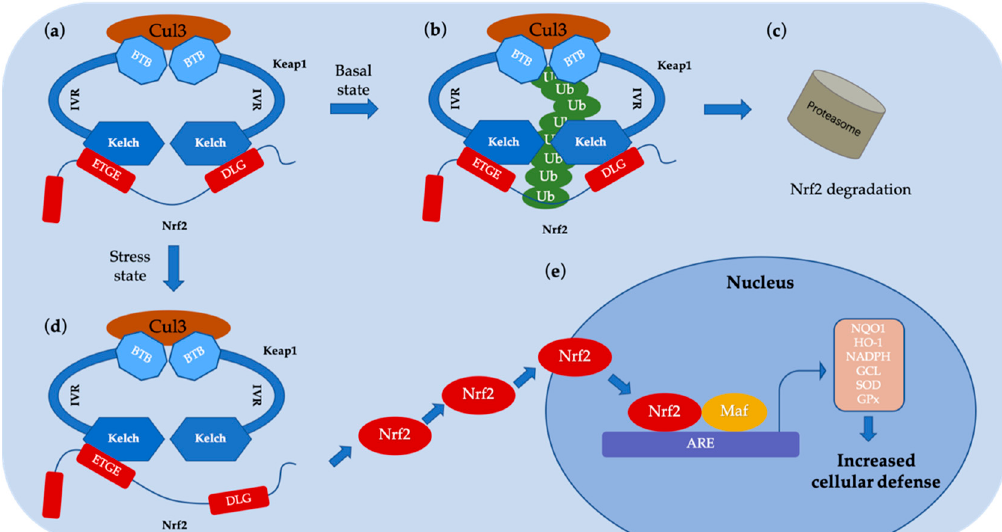
Figure 2. Schematic representation of the Nrf2–Keap1 signaling mechanism. ( a , b and c ) Under normal conditions, Keap1 interacts with the ETGE and DLG motifs on Nrf2 and allows Nrf2 to enter the Keap1–Cul3 ubiquitin ligase complex, resulting in the ubiquitination and then degradation of Nrf2; ( d ) Under stress conditions, the inducer modifies the key cysteine residue of Keap1, leading to the repression of Nrf2 ubiquitination by dissociation inhibitory complexes. In the hinge and latch model, modification of as specific Keap1 cysteine residue results in a conformational change in Keap1, leading to the release of the Nrf2 DLG motif from Keap1. Nrf2 ubiquitination is prevented, but binding to the ETGE domain is still retained, resulting in Nrf2 escaping from the ubiquitination system; ( e ) Nrf2 protein bypasses Keap1 and moves into the nucleus, interacts with the ARE and stimulates Nrf2 targets. Transcription of genes including quinone oxidoreductase 1 (NQO1), heme oxygenase-1 (HO-1), nicotinamide adenine dinucleotide phosphate (NADPH), glutamate–cysteine ligase (GCL), superoxide dismutase (SOD), glycopeptide peroxidase (GPx), increases the defense of cells against oxidative stress.